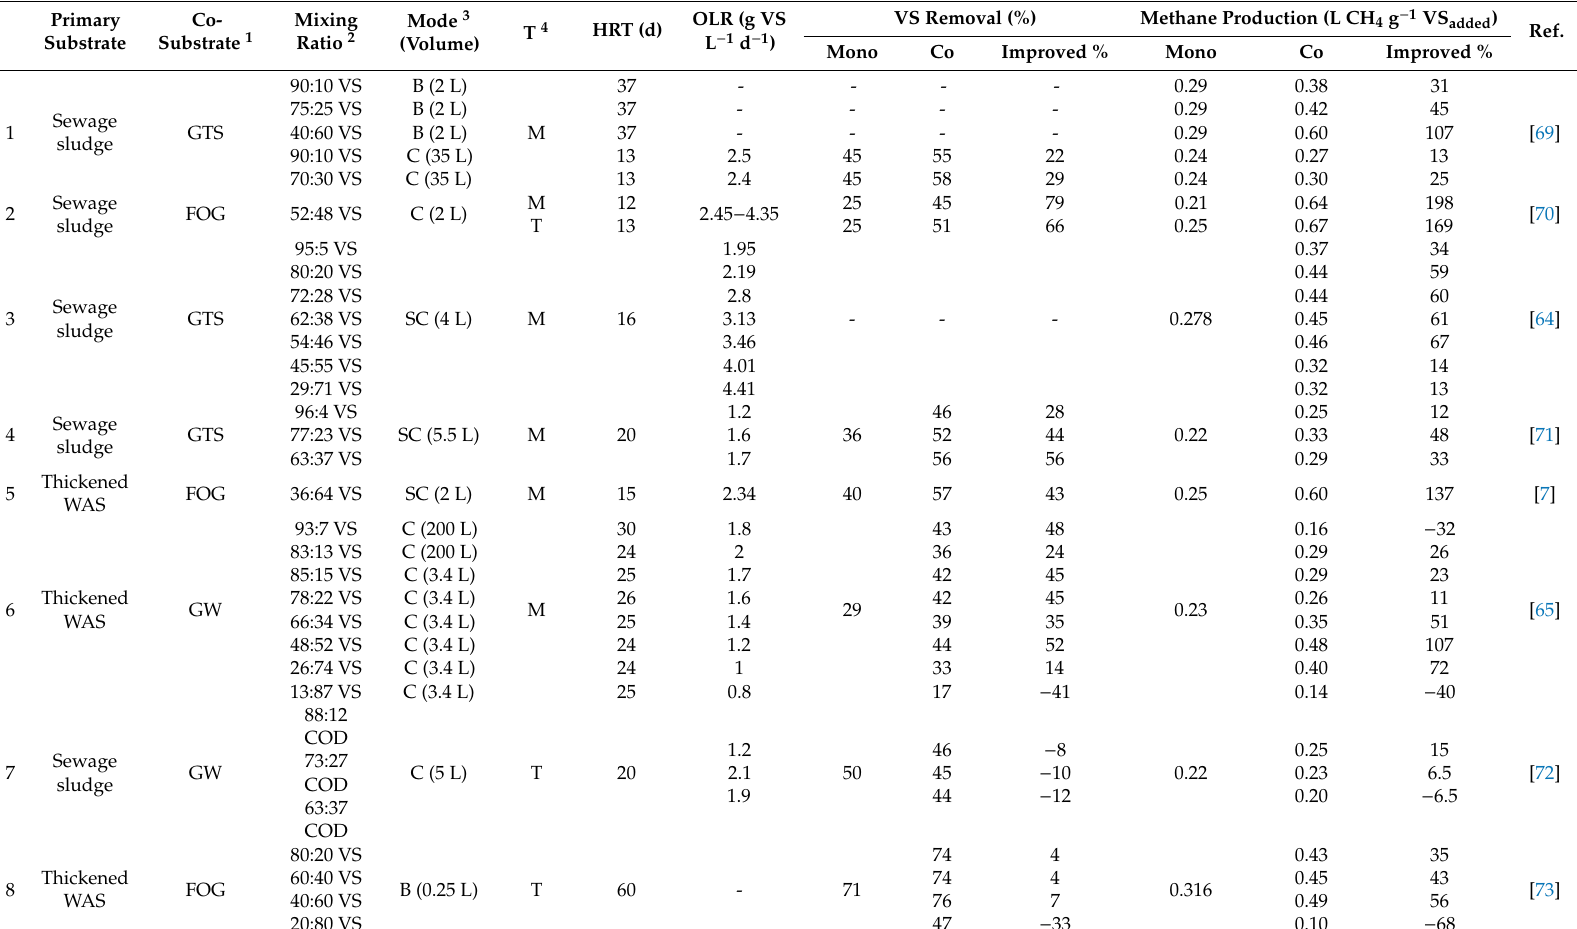
Table 5. Summary of studies utilizing FOG as a co-substrate in wastewater sludge